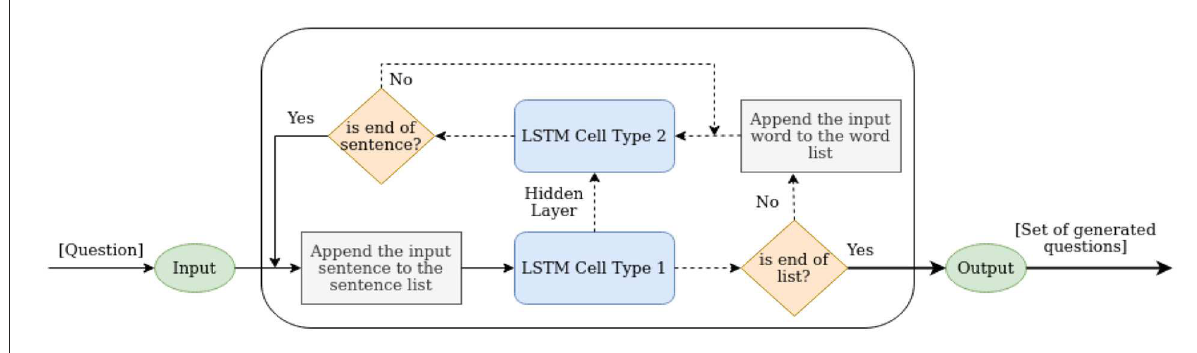
FIGURE2 An illustration of an LSTM-cell in QG-LSTM. Similar is the architecture of QG-T.